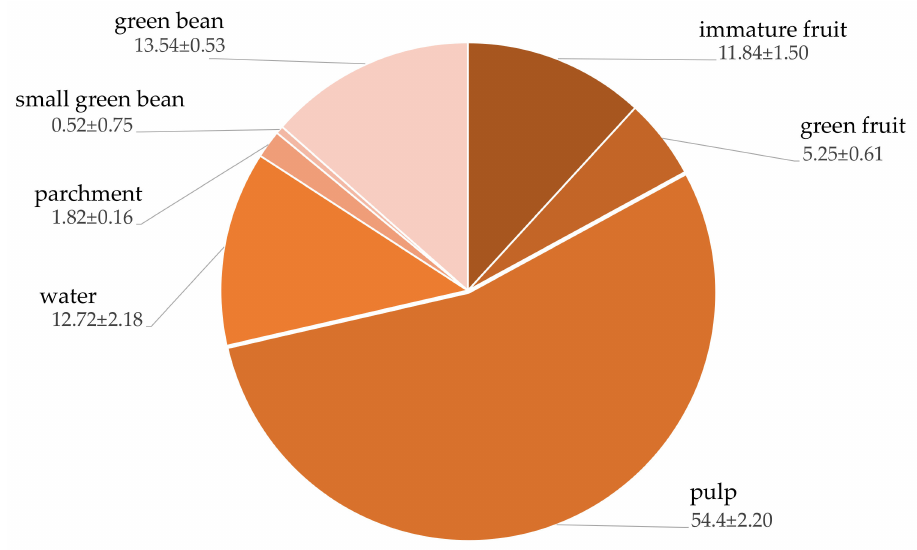
Figure 1. Losses and types of by-products from Arabica coffee